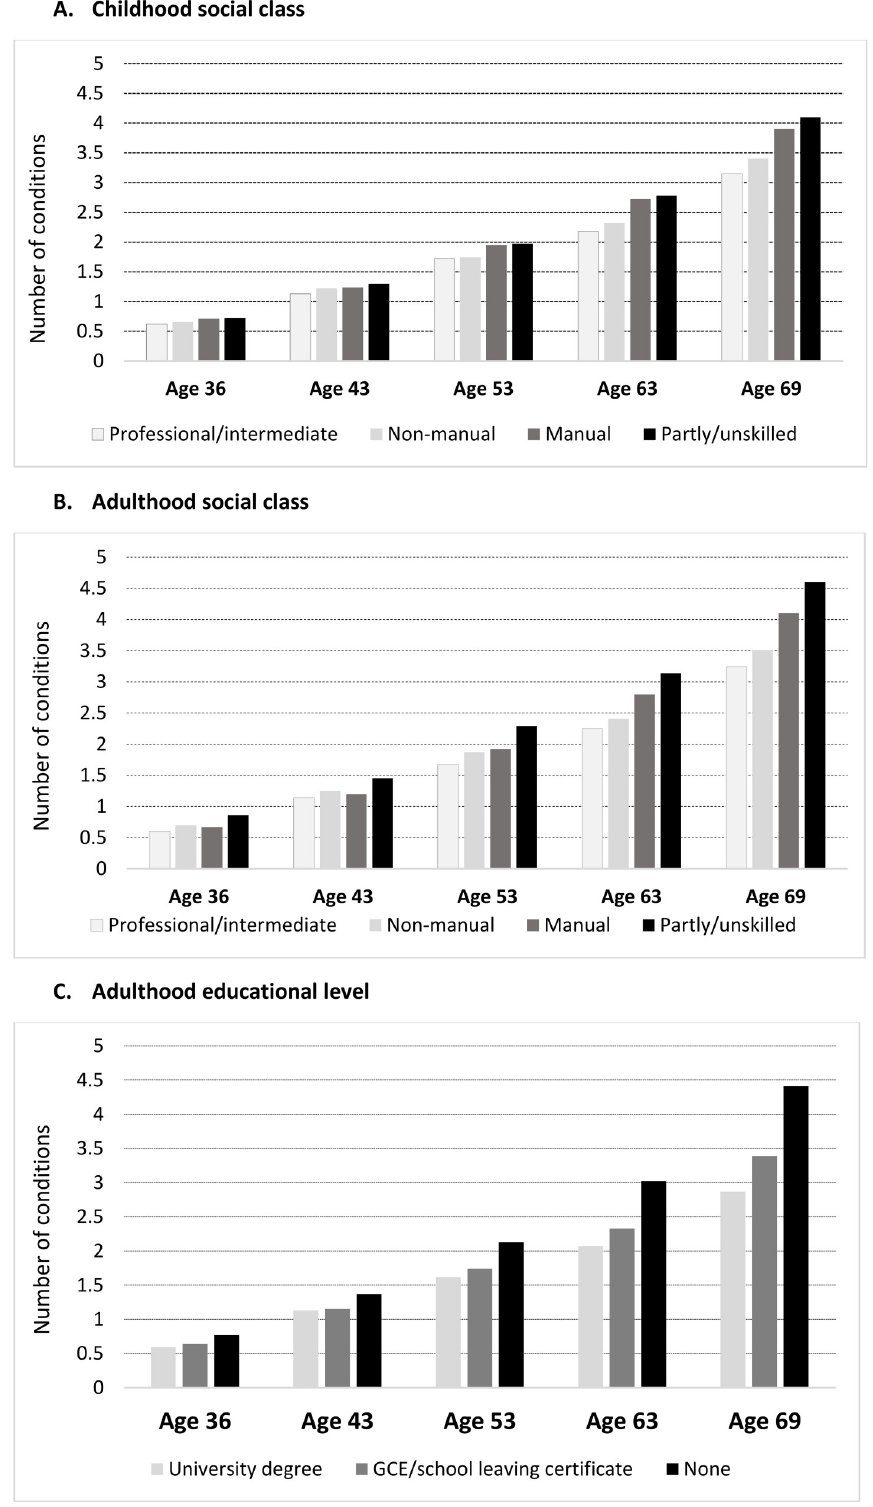
Fig 3. Mean number of morbidities at each age by socioeconomic indicators in 3,723 participants from the 1946 MRC NSHD. GCE, General Certificate of Education; NSHD, National Survey of Health and Development.